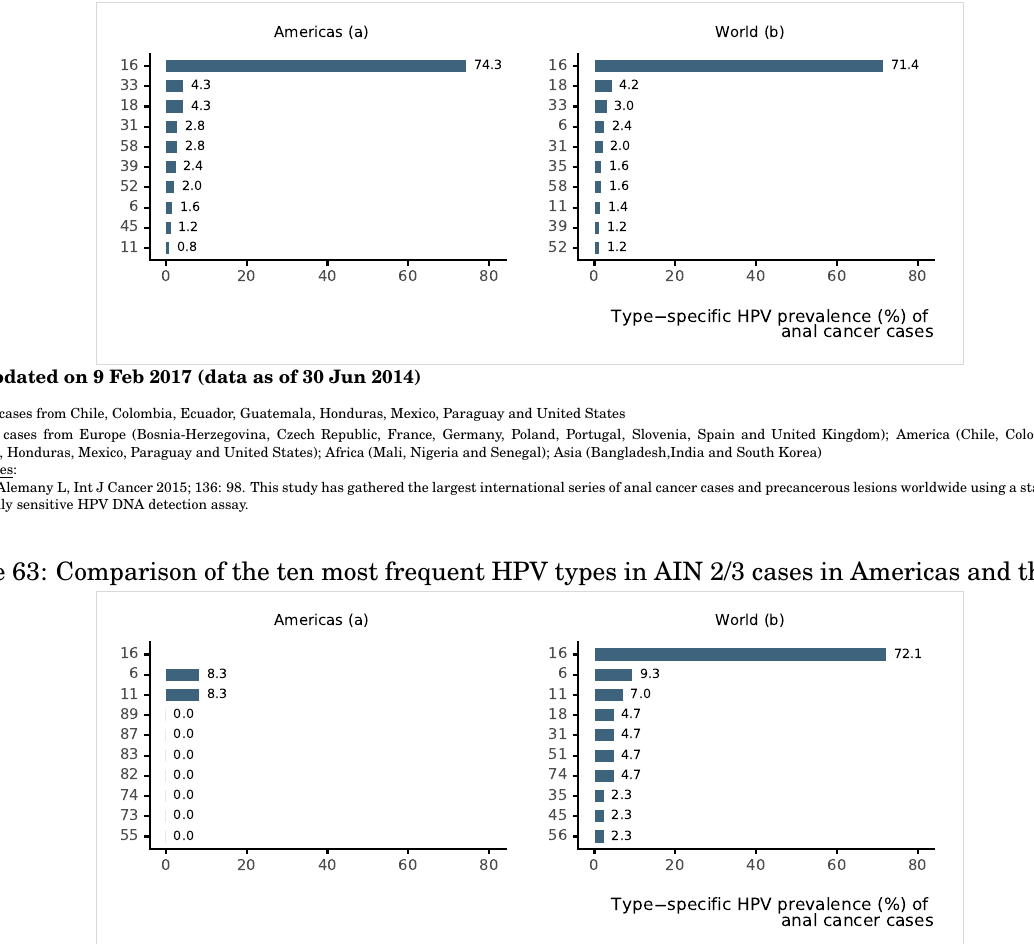
Figure 62: Comparison of the ten most frequent HPV types in anal cancer cases in Americas and the World